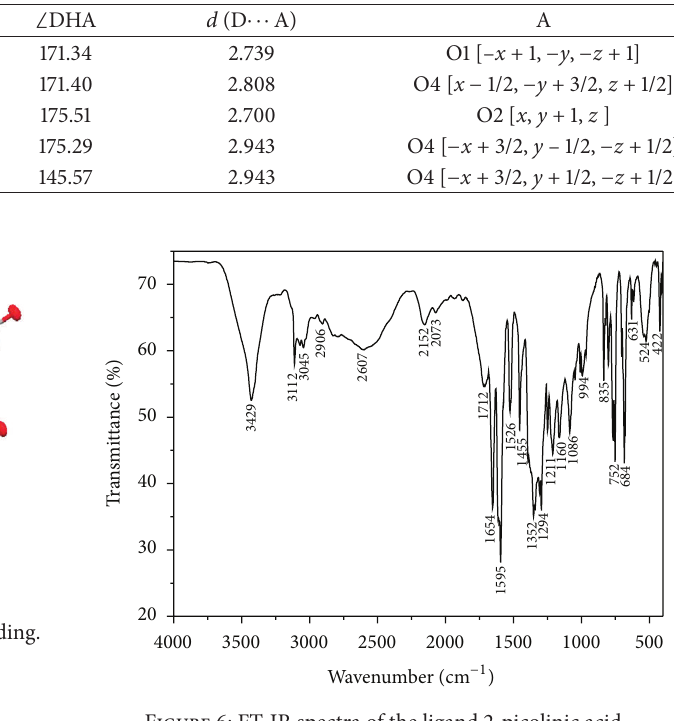
Figure 6: FT-IR spectra of the ligand 2-picolinic acid.